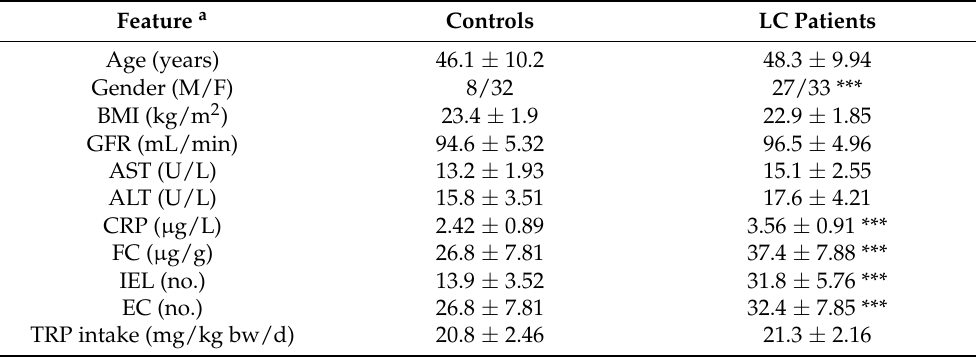
Table 1. Characteristics of control individuals (n = 40) and patients with lymphocytic colitis (LC, n = 60) enrolled in this